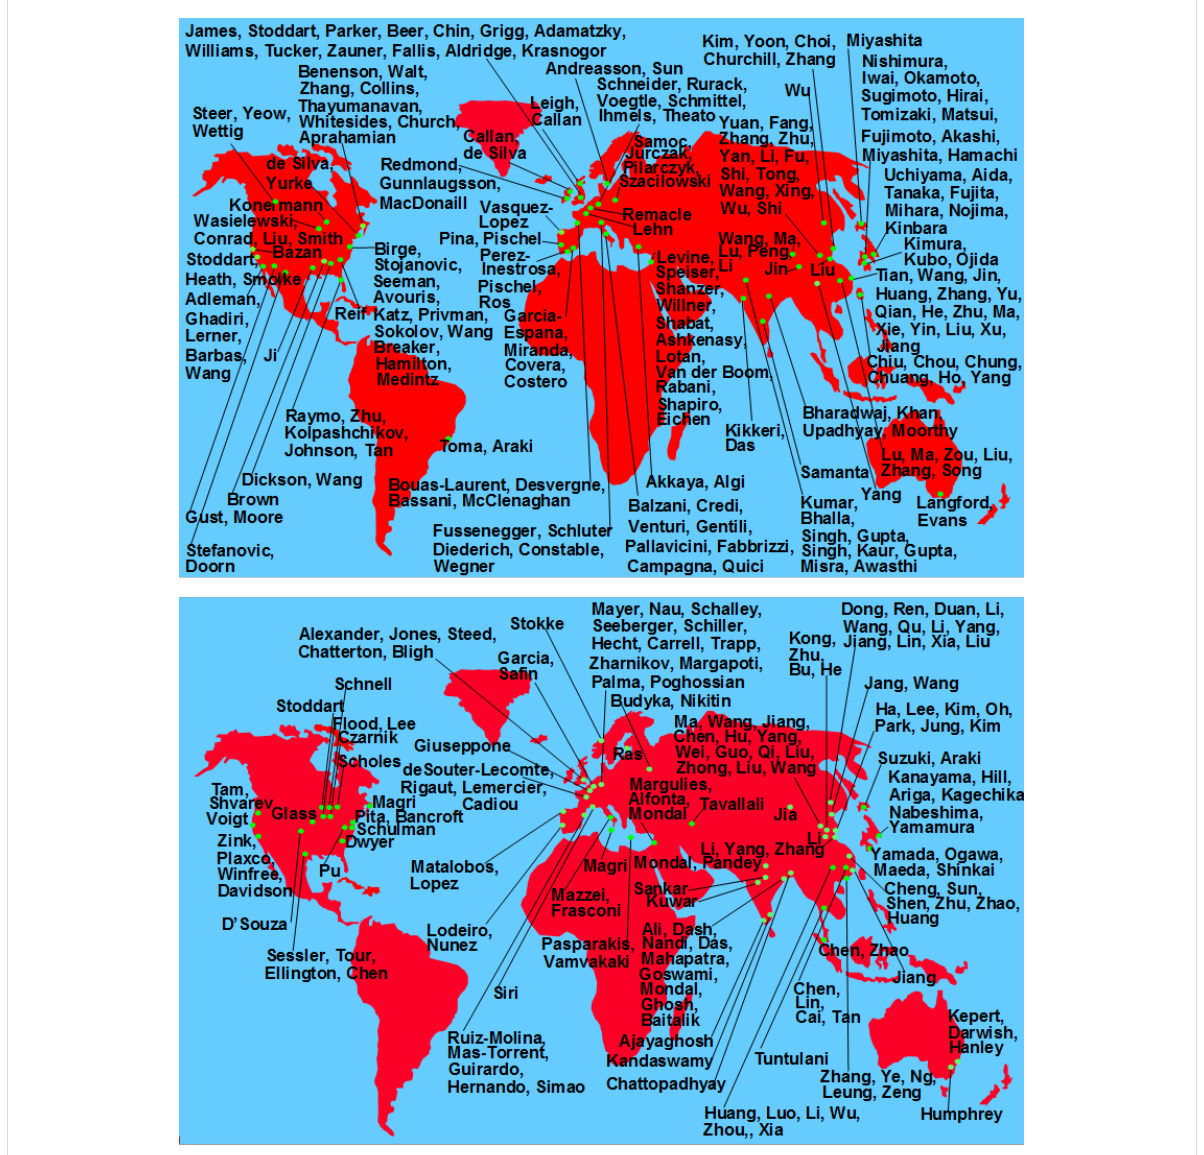
Figure 4: Approximate world maps of the sources of molecular logic devices. Only the names of corresponding authors from the literature are given. The simplest cases of single-input, single-output binary logic devices are not included. Adapted from [65], Copyright (2015) The Royal Society of